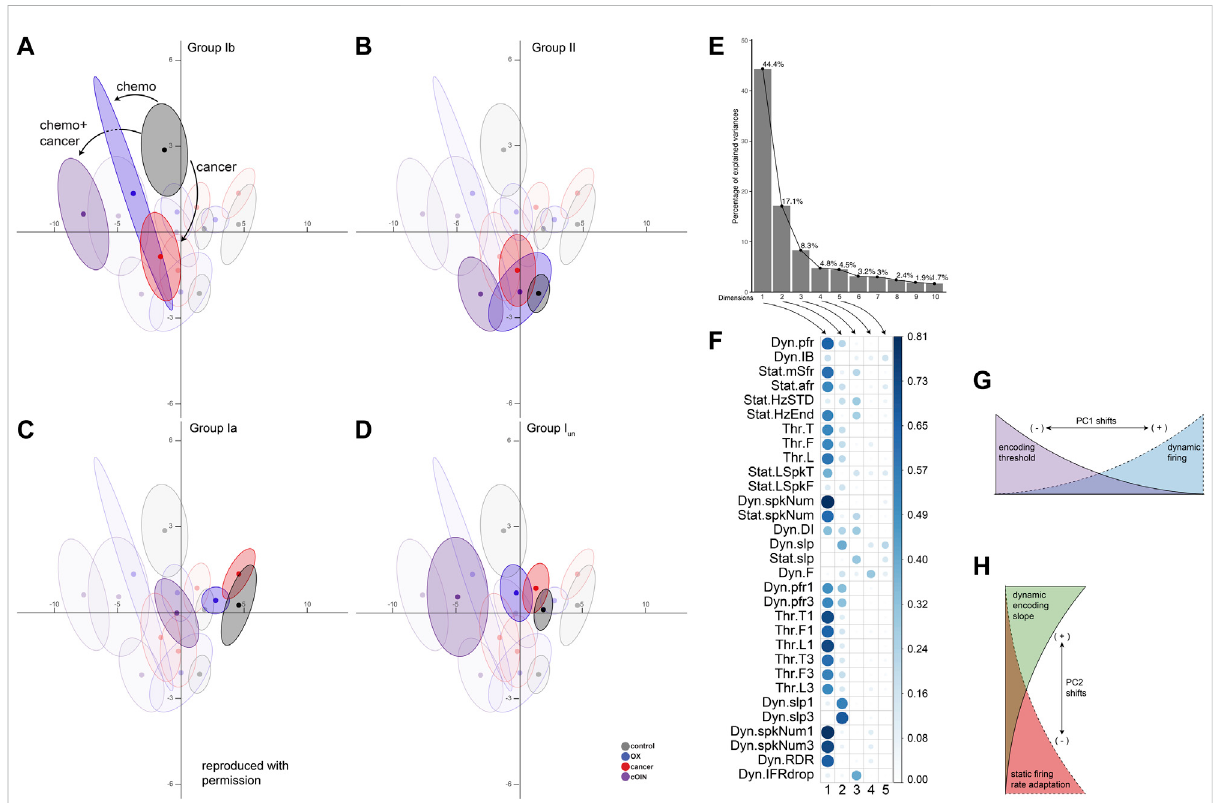
FIGURE 3 Latent encoding space reveals unique effects of cancer, chemotherapy and their combination across divergent classes of propriosensors. Principal component (PC) analysis applied to all ( n = 31) encoding parameters measured in response to natural stimuli for each neuron class emphasizing: spindle group Ib (A) , group II (B) , group Ia (C) , unclassi fi ed spindle (D) with greater opacity. Neuron class means (average of PC1-2 coordinates across all neurons in a given class and treatment group: dark colored circles) are visualized in the new latent encoding space created by PC1 – 2. Color-coded least-squares elliptical fi tting (95% con fi dence) was computed to emphasize differences between neuron classes and experimental groups. Labelled arrows in (A) indicate the magnitude and direction of cancer, chemotherapy, or their combined effects. (E) Scree plot indicating percentage of explained variance by each PC (grey bar, eigenvalue in %). (F) Corrplot indicates the contribution of variables on the factor map for PC1-5. Larger values indicate the components contribute a larger relative portion, indicating components are of greater importance. (G,H) Summarize the effects of shifting along principle axes in latent encoding